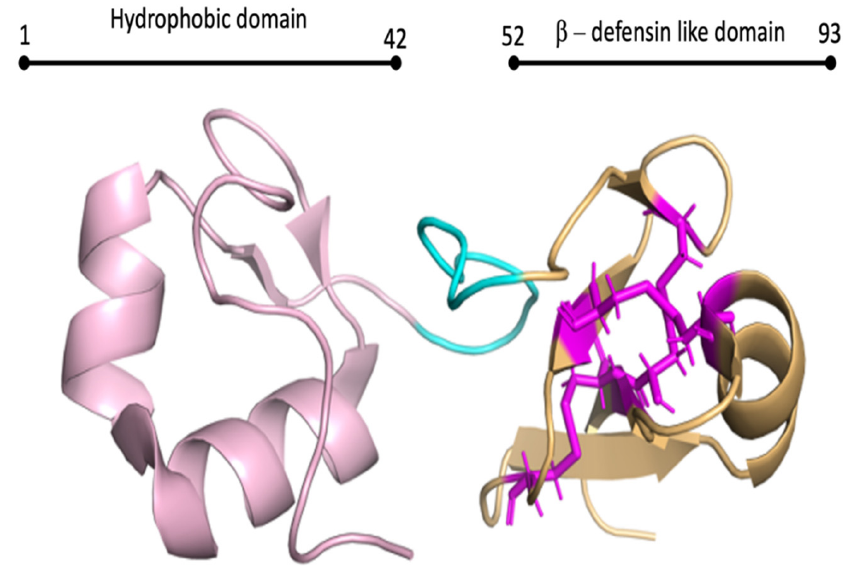
Figure 2. NMR structure of Cg -BigDef1 structure (6QBL). The N-terminal hydrophobic domain is represented in light pink (residues 1–42), the linker in cyan and β -defensin-like domain is light orange (residues 52–93). The critical cysteines that form disulfides are represented in mangta.